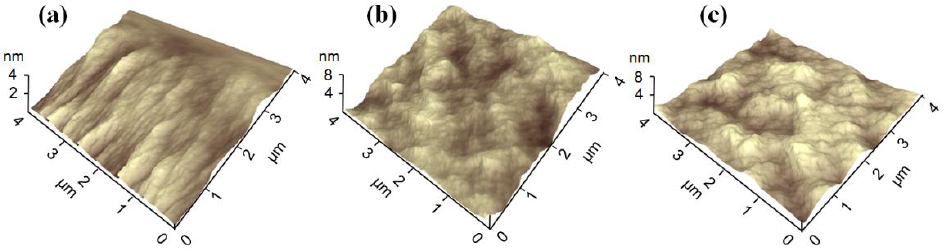
Figure 7. AFM images of ( a ) untreated PI film and plasma-modified PI films by ( b ) pure Ar and ( c ) Ar/H 2 O microplasma jets.